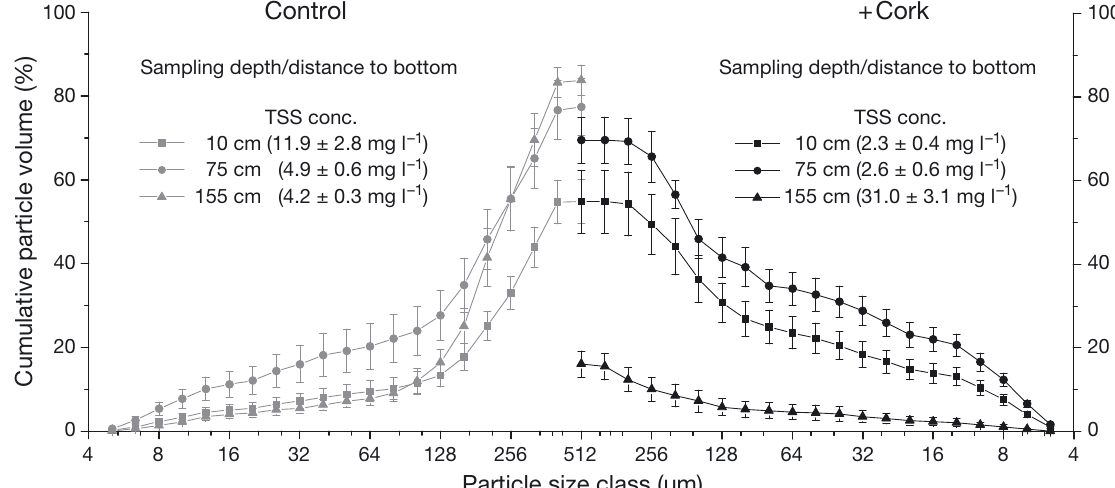
Fig. 14. Volume-dependent cumulative size distributions for suspended particles collected during the cork and control phases of the diet trial. Values are mean ± SE. Water depths from the tank bottom of sampling points with the respective total sus- pended solids (TSS) concentrations (in brackets) are